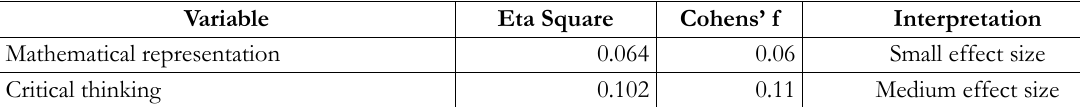
Table 16. Effect size